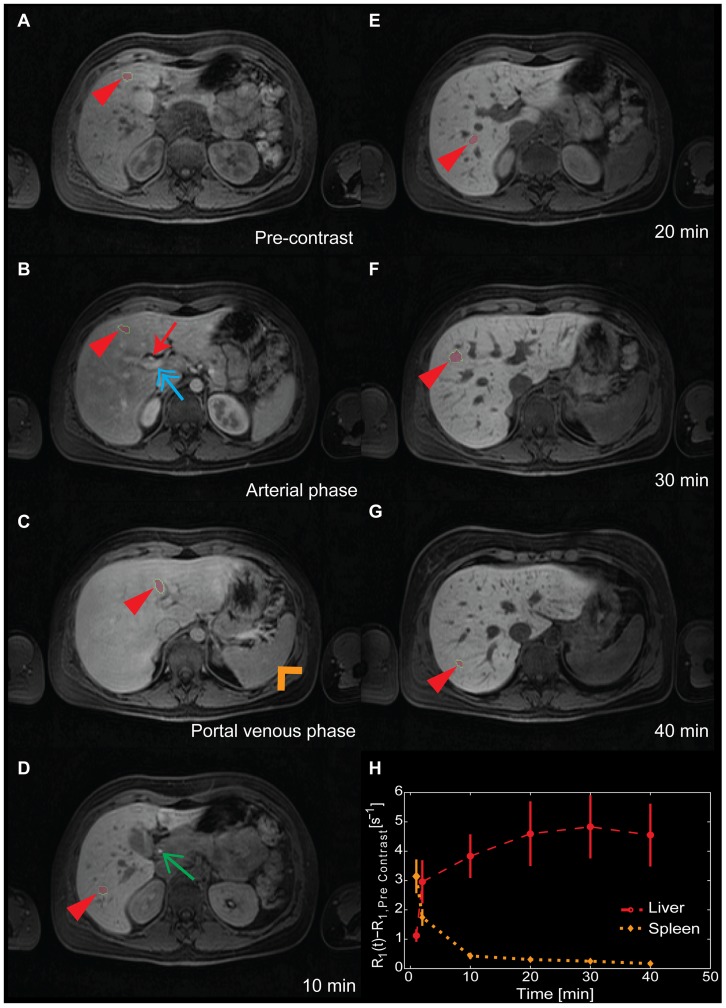
Estimation data.Example of the spatially highly resolved DCE-MRI that was used as estimation data, showing the pre-contrast acquisition (panel A), followed by the post-contrast acquisitions (panels B–G) with a distinct accumulation of the contrast agent in the liver. The dark areas within the liver in the late phases (panels D–G) are mainly blood vessels with drastically lower concentration of contrast agent compared to the accumulated contrast agent in the hepatocytes. This difference can be appreciated quantitatively in panel H, since the increase in signal intensity in the spleen is only due to the CA residing within the blood plasma. The location of the seven different regions of interest placed in the liver are shown throughout the time series (panels A–G, one in each panel), indicated by the red arrow heads. The hepatic artery, with a high initial concentration of contrast, can be seen in panel B (red arrow) as well as the portal vein (blue double arrow). In panel C the spleen (orange open arrow head) is almost isointense with the liver. The efflux of CA in the common bile duct can be seen in panel D (green arrow). Finally, the quantified mean relative change in relaxivity in the ROIs placed in the liver and spleen throughout the examination is shown in panel H, with the vertical bars corresponding to the standard error of the mean.